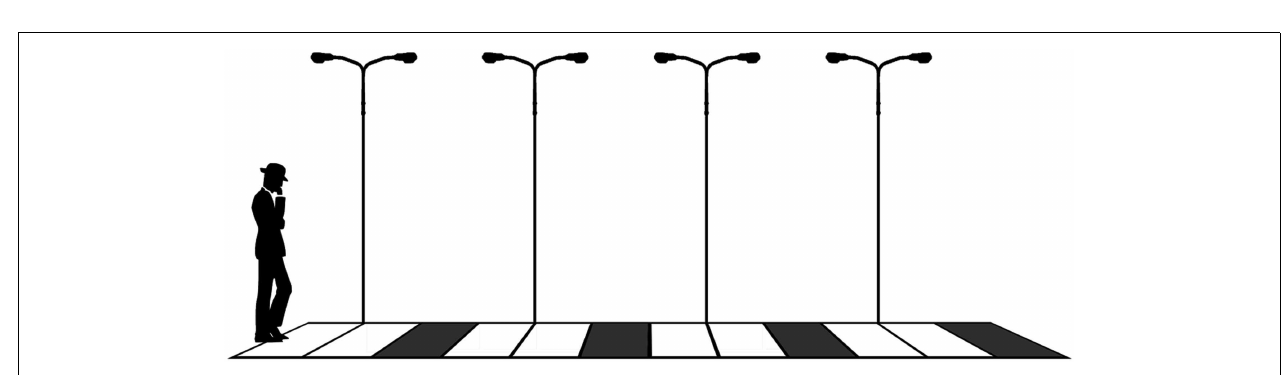
FIGURE 4 | Illustration of the example of the man going on the road to his